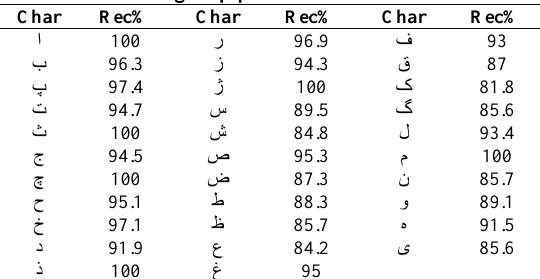
Table 3. Recognition percent of each character within each group presented in table 3.